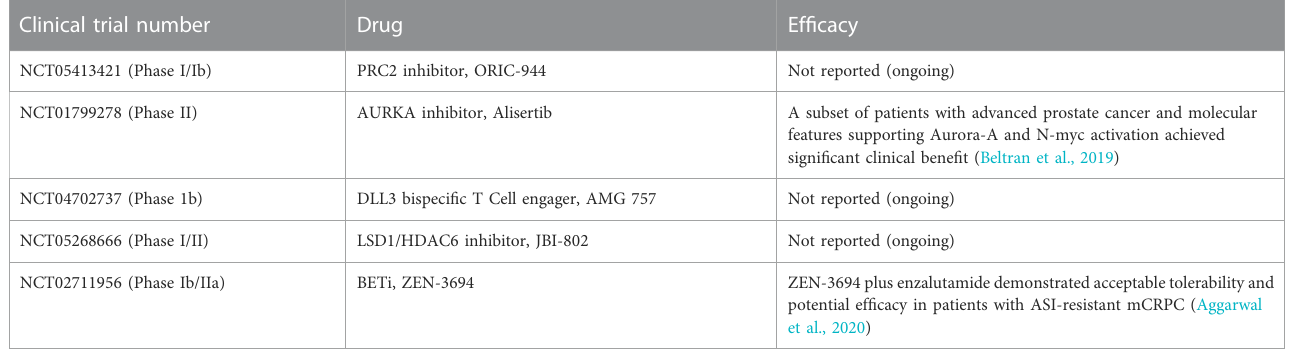
TABLE 2 Clinical Trials in NEPC focused on TFs, chromatin modi fi ers and other proteins. Clinical trial